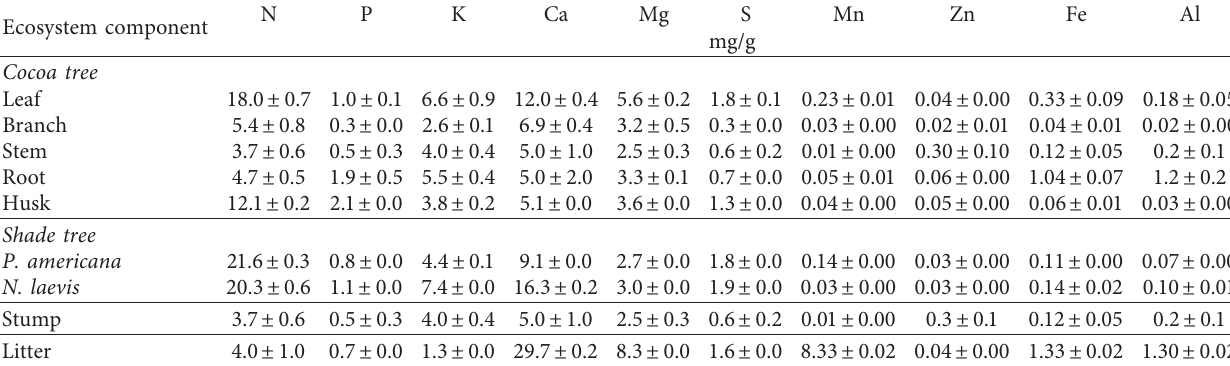
Table 1: Nutrient concentrations ( ± standard error) in cocoa tree components (leaf, branch, stem, root, and husk), stumps, litter, and leaves of shade trees ( Persea americana and Newbouldia laevis ) in cocoa ecosystems of Ghana ( n � 3). Ecosystem